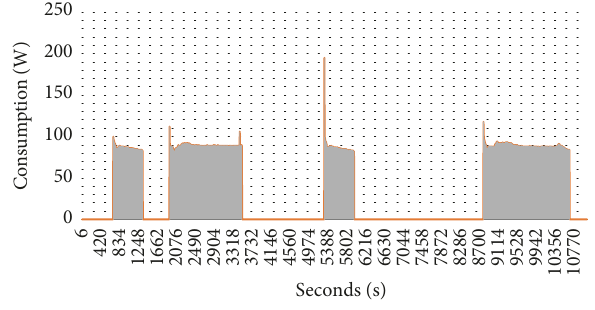
Figure 3: Line connected to a